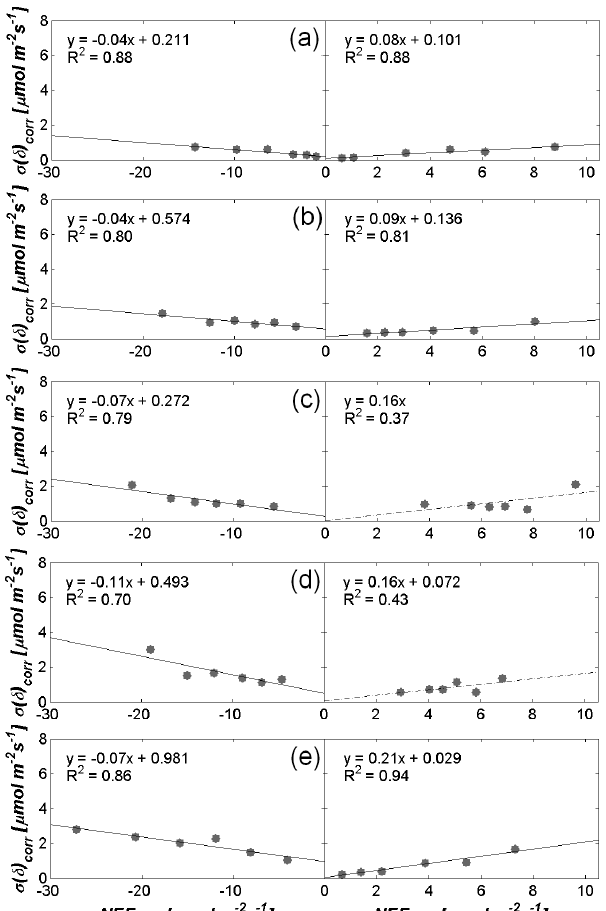
Figure 6. NEE uncertainty σ(δ) corr determined with the extended two-tower approach as function of sfd-corrected NEE corr magni- tude (Eq. 2) including application of the weather filter for the EC tower distances 8m (a) , 95m (b) , 173m (c) , 20.5km (d) and 34km (e) ; dashed line: linear correlation not significant ( p >